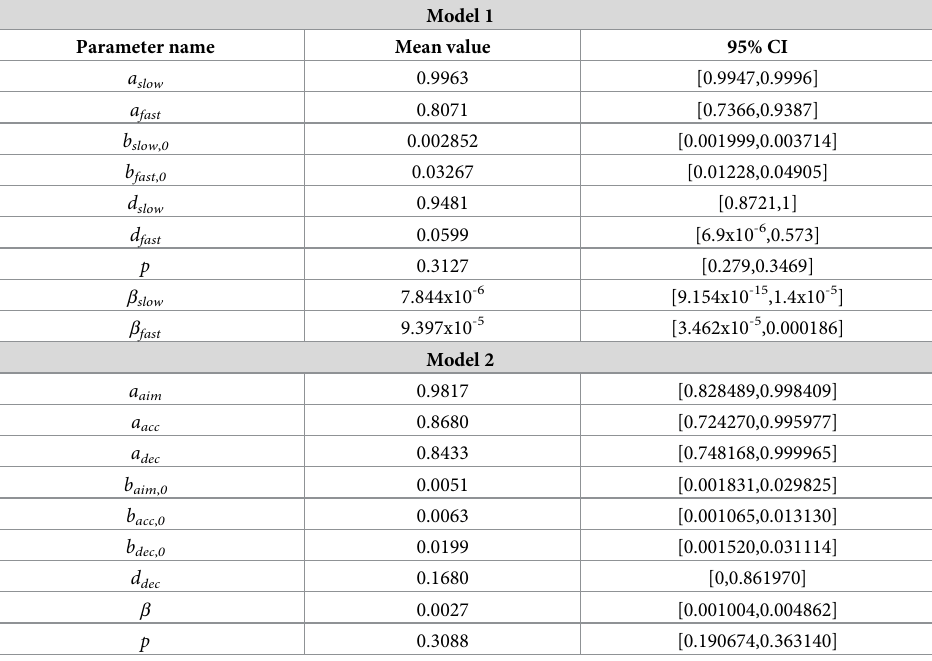
Table 1. Parameter values and confidence intervals for Models 1 and